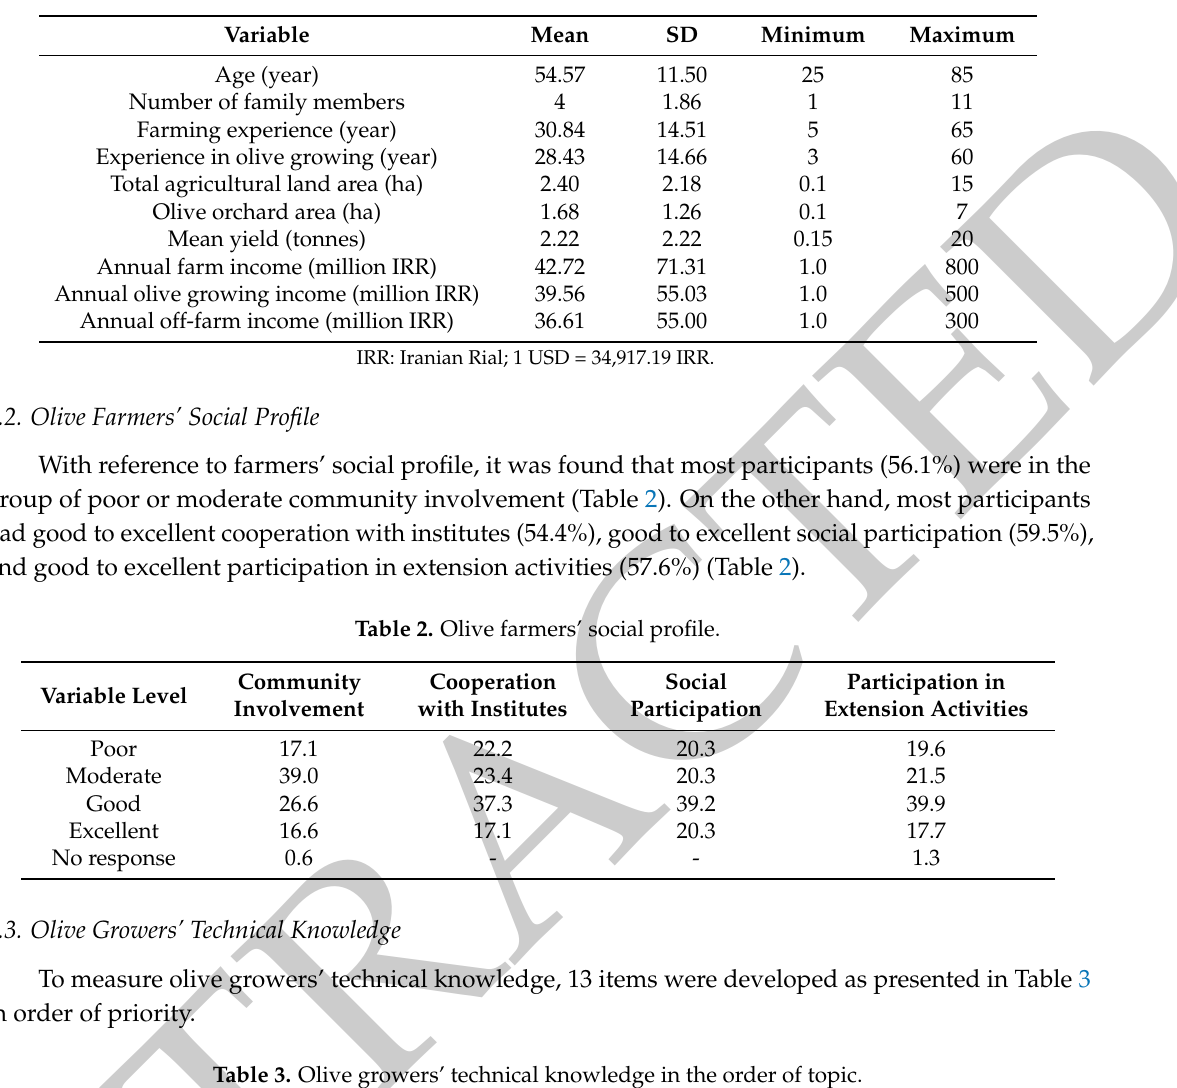
Table 3. Olive growers’ technical knowledge in the order of